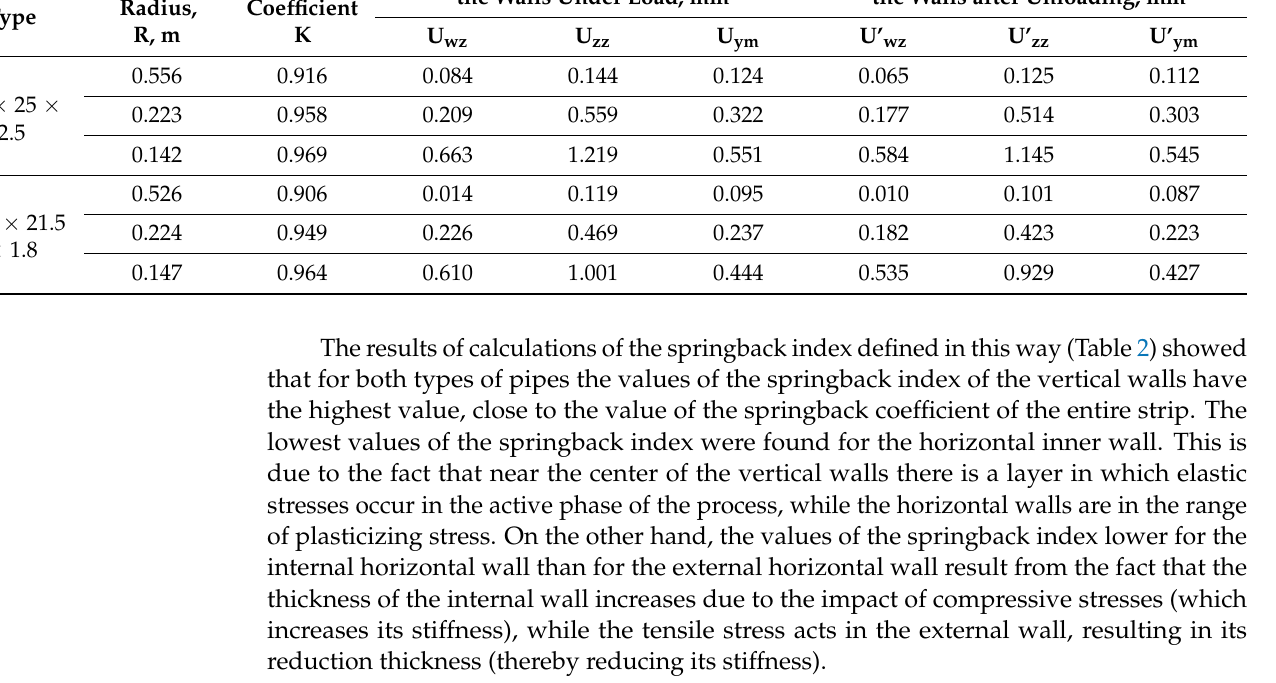
Table 2. The values of the walls springback index of the 25 × 25 × 2.5 and 21.5 × 21.5 × 1.8 profile.